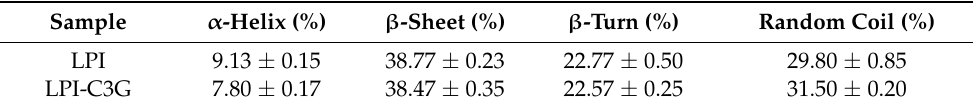
Figure 3. CD spectra ( A ), UV–vis spectra ( B ), synchronous fluorescence spectra at ∆ λ = 15 nm ( C ) and ∆ λ = 60 nm ( D ), FTIR spectra ( E ), and intrinsic fluorescence spectra ( F ) of LPI-C3G complexes (0.5 mg/mL LPI) at 298 K. Table 1. CD analysis of the secondary structure of LPI with and without C3G at 298 K.